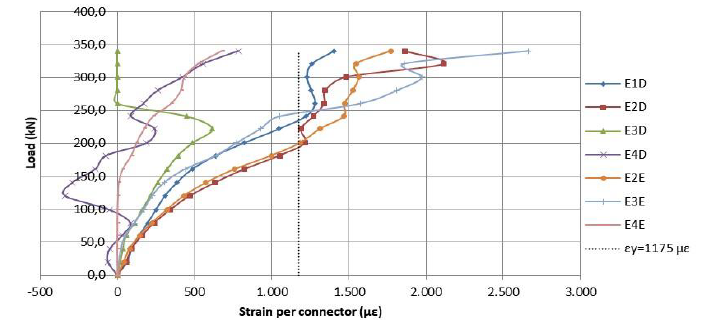
Figure 28. Load x strain per connector curve – V2A.